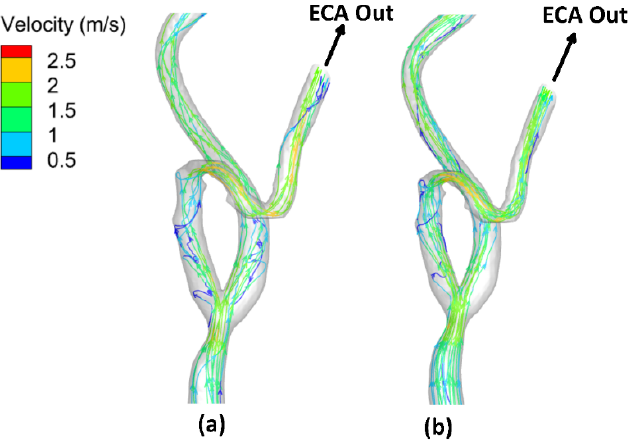
Figure 9. Streamlines at the peak systole for stenotic CCA (model C) of the CA: ( a ) elastic wall, ( b ) rigid wall.